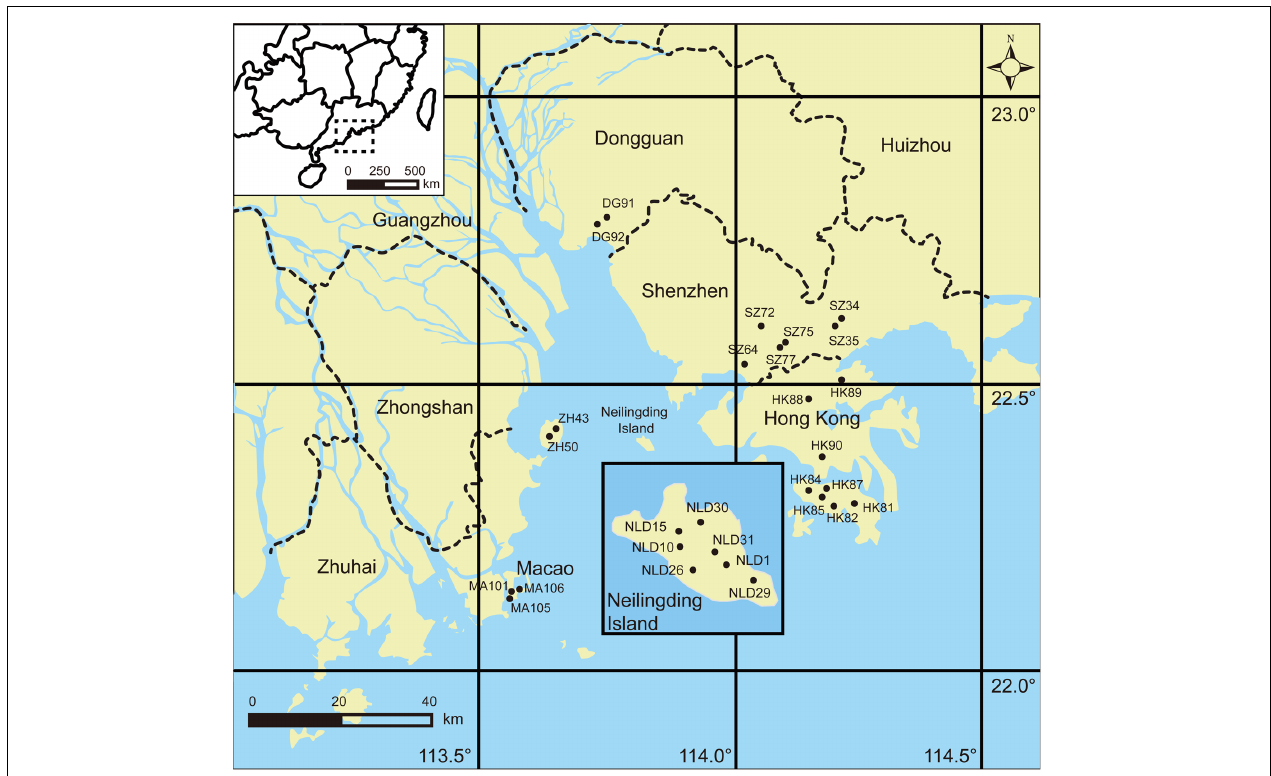
FIGURE 1 | Detailed sampling locations of M. micrantha in southern China shown by black solid points.